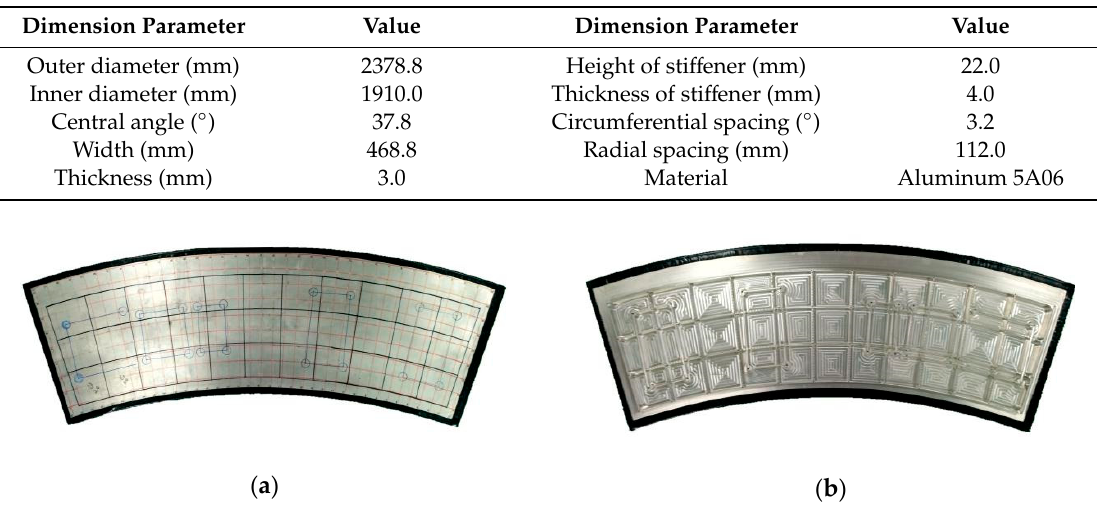
Table 4. The parameters of the fan-ring shaped high-sti ff ened panel.